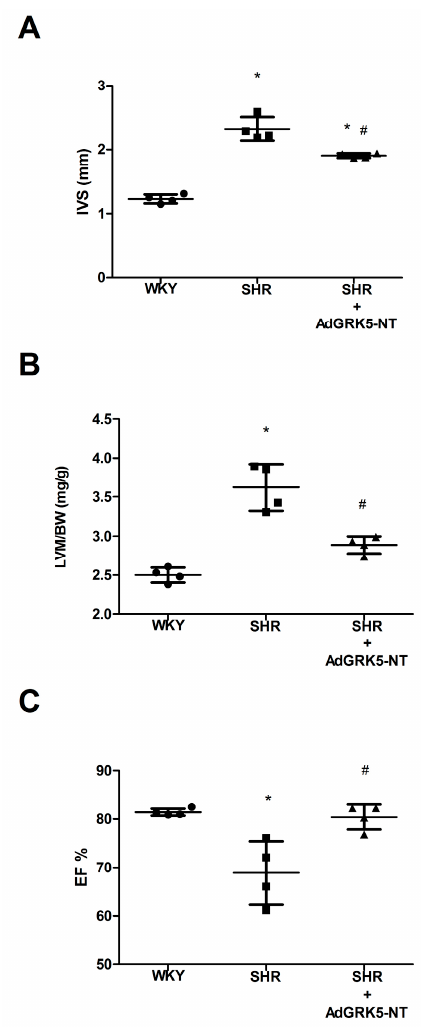
Figure 3. The amino-terminal domain of the G Protein Coupled Receptor Kinase 5 (GRK5-NT) inhibits calcium-calmodulin dependent transcription factors in vivo. ( A – C ) Spontaneously hypertensive and hypertrophic rats (SHR) were treated with an intra-myocardial injection of an adenovirus encoding for GRK5-NT (AdGRK5-NT) or Lac-Z (AdLac-Z), as described in methods, and cardiac hypertrophy was evaluated by echocardiography. 21 days after injection, a reduction of IVS ( A ) and LVM/BW ( B ), was found in AdGRK5-NT versus SHR controls. Cardiac function was recovered in treated SHR vs. SHR ( C ) * p < 0.05 vs. WKY and # p < 0.05 vs. SHR + AdLac-Z.